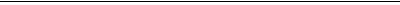
Figure 3 . Dependence of the allowed region on N p ; i N p ; i : 10 (cid:0) 1 (yellow), 10 (cid:0) 2 (red), 10 (cid:0) 3 B (cid:0) L